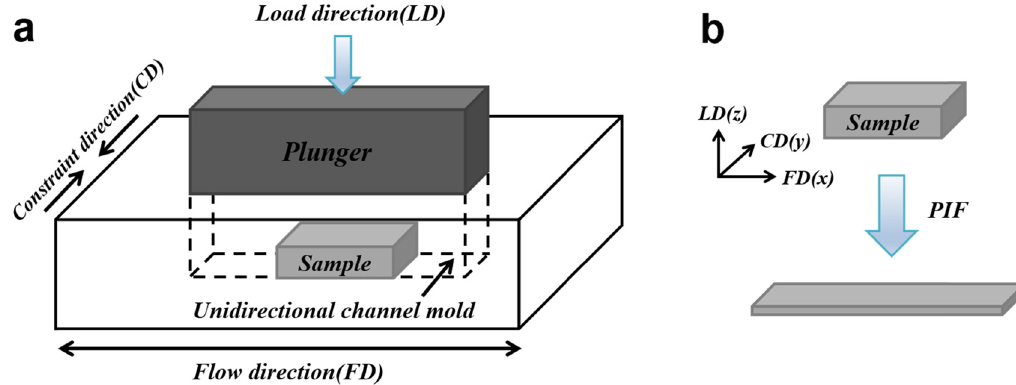
Figure 5: Schematic diagram of ( a ) PIF processing, ( b ) shape